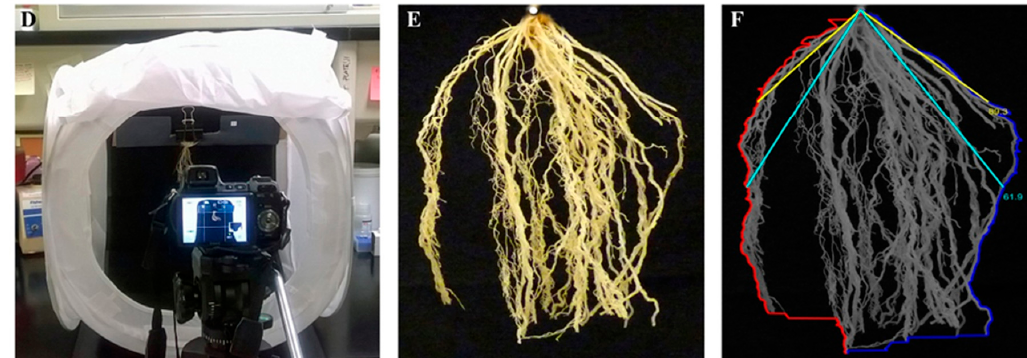
Figure 3. Root angle characterization in two wheat cultivars subjected to defoliation. ( A ) Root angle distribution in depth. Roots where divided into 10 segments of 1 cm each. The graph shows the average root angle within these segments. The different colored lines represent cultivar-treatment combinations. The black square marks the root area where angle values differ the most, i.e., between the sixth and the eighth segments. ( B ) Surface root angle distribution. The graph represents the root angle average of the first three segments of roots. ( C ) Root angle distribution in depth. Root angle average between 6 and 8 cm segments was calculated and represented per each cultivar and treatment. ( D ) Image acquisition system for root angle measurements. ( E ) Representative photo of the first 10 cm of the root of a 10-week-old wheat plant, obtained with the system shown in ( D ). ( F ) Software used to quantify root angle in wheat roots. The crown of the plant was chosen as the vertex. From the vertex, two lines (blue and red in F ) were drawn to mark most external roots. Root angle was defined as the angle in degrees between two intersecting lines that started from the vertex and extended separately to the left and right curves at the same vertical distance from vertex. Yellow and cyan lines in ( F ) represent two examples of root angle measurements. Yellow lines show root angle at 25% of vertical root length. Cyan lines represent the angle at 50% of vertical root length. No leaves clipped = NC, 40% of the leaves clipped = 40% C or 40 C, and 100% of the leaves clipped = 100% C or 100 C. Duster = D and Cheyenne = C. Error bars represent standard deviation of the mean. N ≥ 13 ten-week-old plants. Statistically significant differences of the means were determined by using one-way ANOVA and Tukey’s tests. Different letters represent distinct means within groups at p < 0.05. Differences in growth between Duster and Cheyenne in the greenhouse were also manifested in their shoots. In the greenhouse, Cheyenne produced more than twice the shoot biomass, and almost three times the number of tillers than Duster (Figure 4A and 4B).